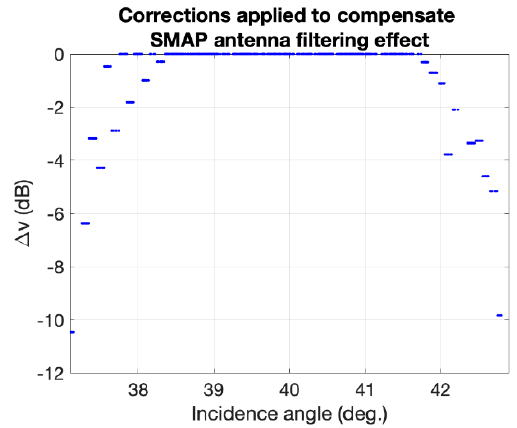
Figure 18. Corrections applied to peak SNR as a function of the incidence angle for February 2018. Corrected peak SNR = peak SNR − ∆ v .